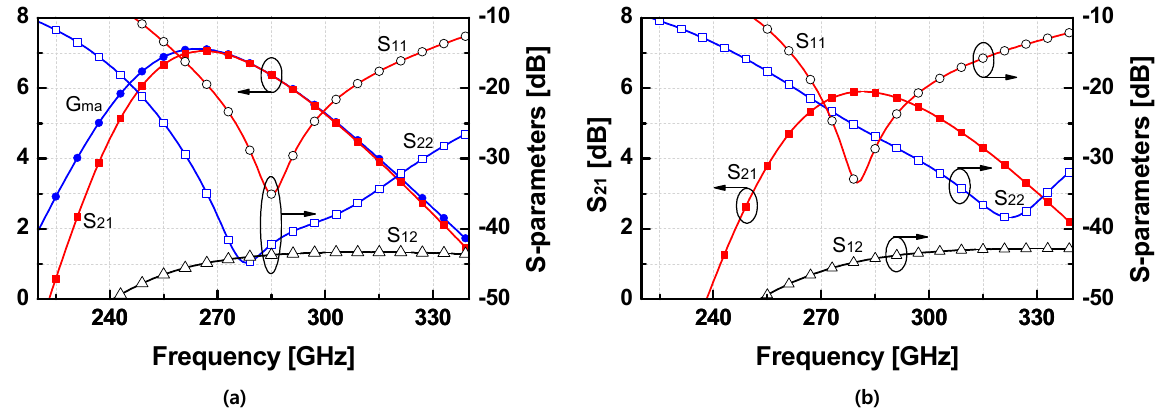
Figure 9. Impedance matching for the input ( a ) and the output ( b ) on the schematic level. The simulated S-parameters of the three-stage amplifier with the designed input, interstage, and output impedance matching circuits on the schematic level are illustrated in Figure 10a. As observed, S 11 and S 22 were below − 30 dB, and S 21 was equal to G ma at 285 GHz. However, the simulation gain peaks at ~267 GHz which is similar to G ma . To flatten the gain at 285 GHz, the optimum impedance matching was performed at a higher frequency so that the peak gain could be tuned to 285 GHz. The simulated S-parameters of the three-stage cascaded amplifier are shown in Figure 10b. Around 0.47 dB of gain degradation was seen compared to the gain in the optimum impedance matching approach.